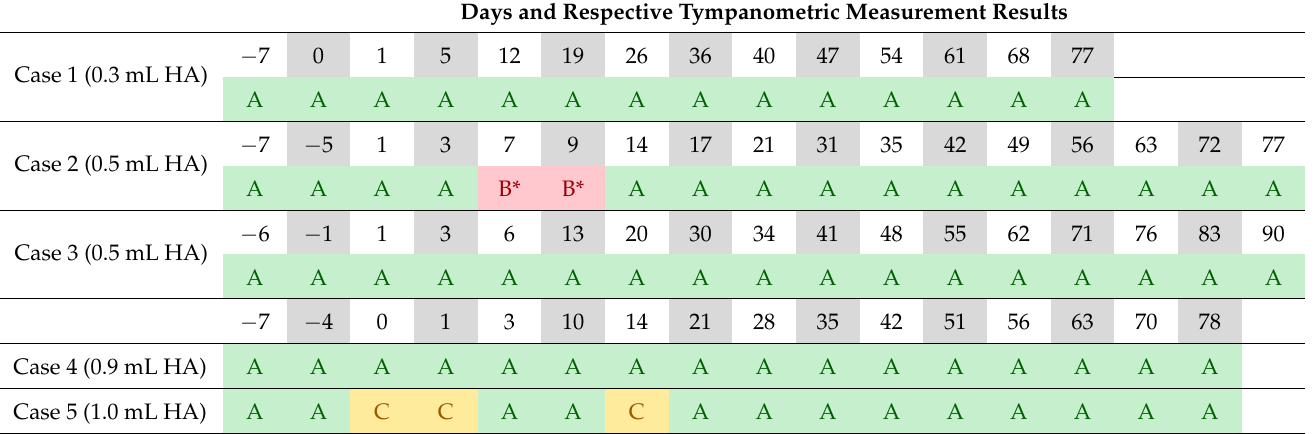
Table 3. Results of tympanometric measurements over the experimental period after injection of non-stabilized HA. Days and Respective Tympanometric Measurement